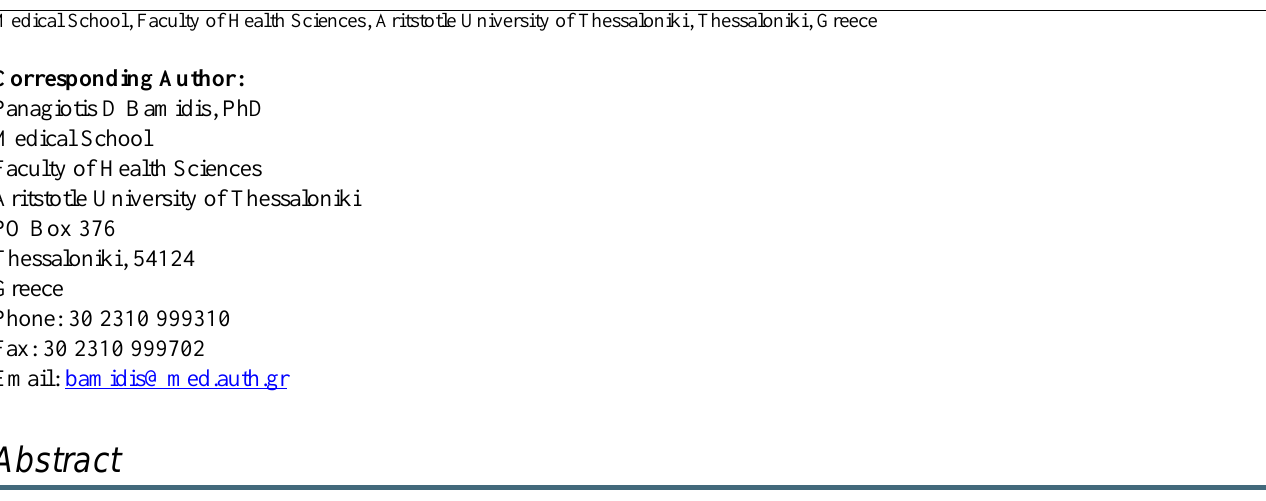
education; medical; dental; focus groups; patient simulation; problem-based learning; video